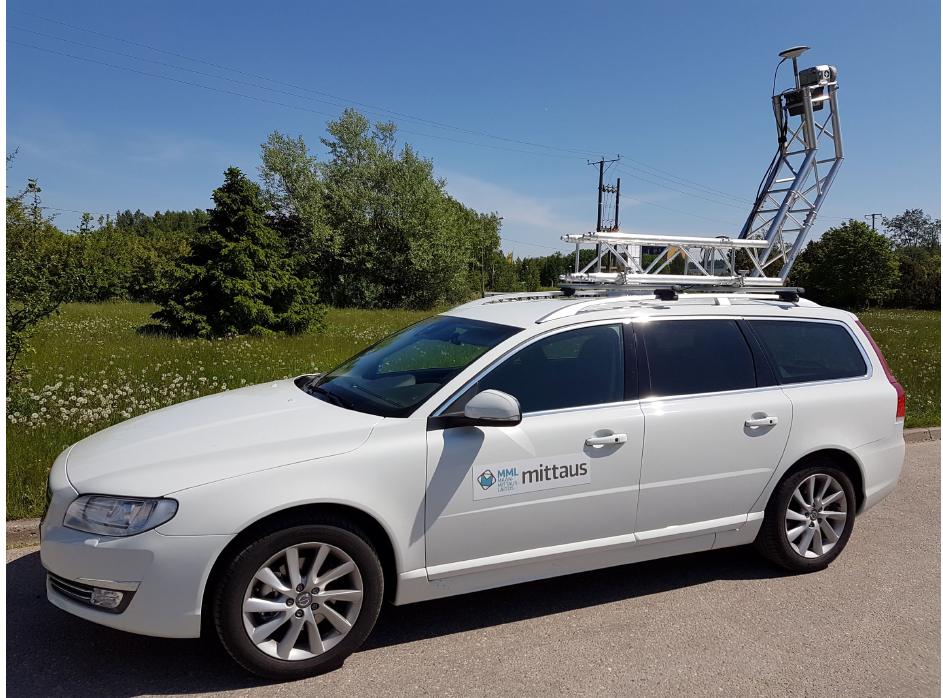
Figure 4. ROAMER R3 mobile laser scanning system installed on top of a truss structure mounted on a